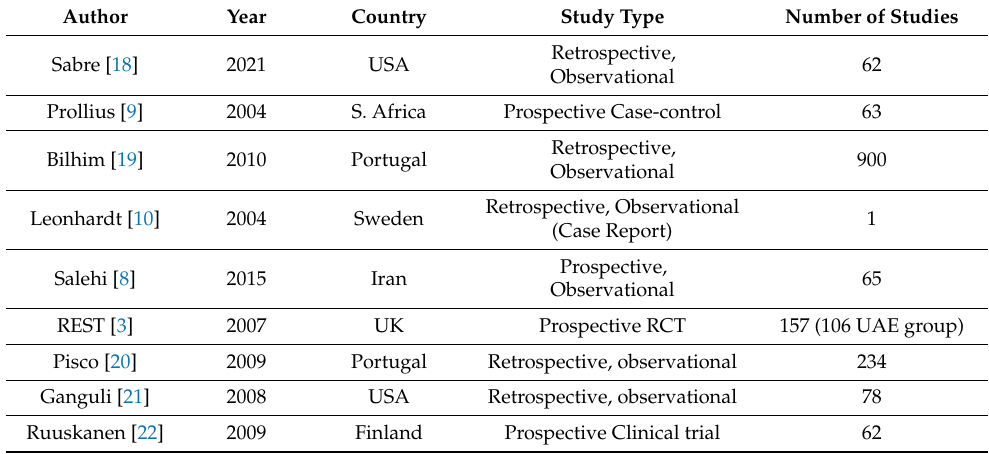
Table 1. Demographic information of included studies.